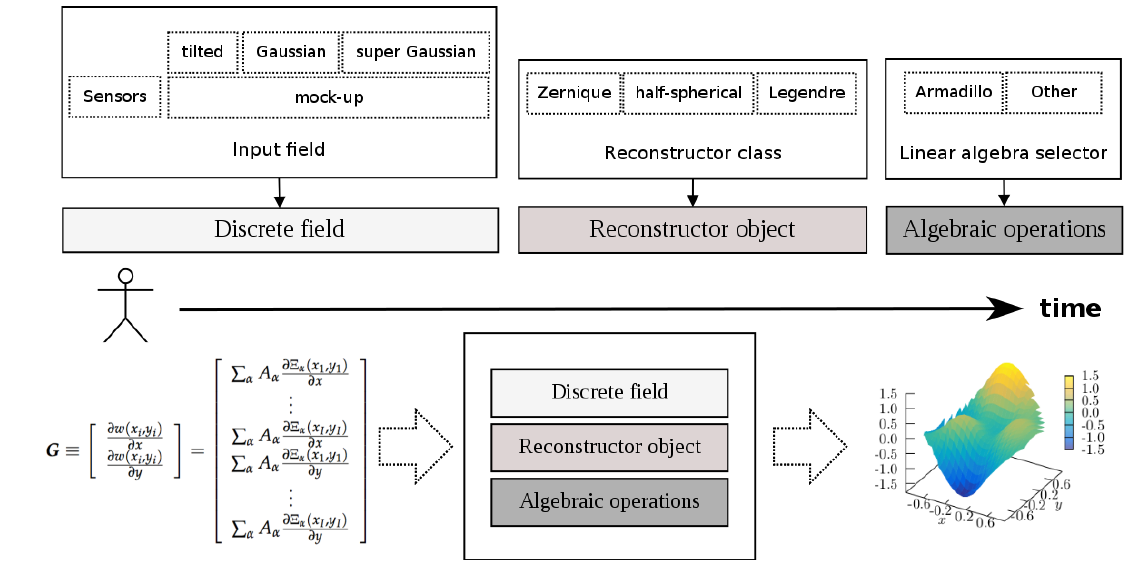
Figure 3. A visual representation of the different possibilities offered by the library for wavefront